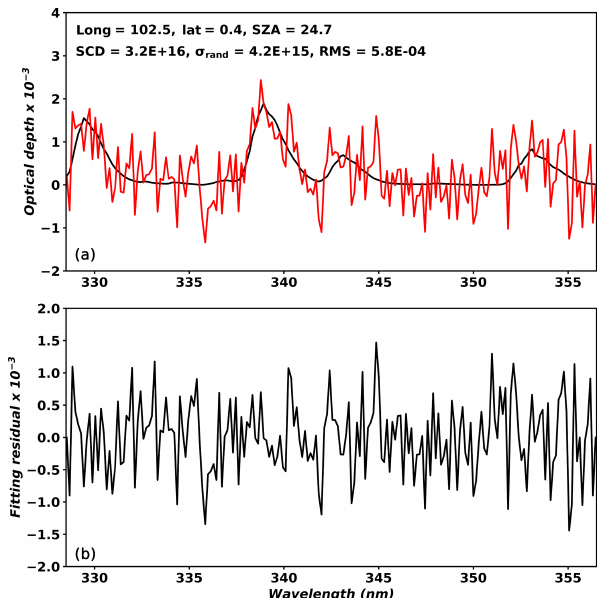
Figure 7. Fitted HCHO optical depth (a) and fitting residuals (b) on a pixel (23 March 2005; orbit 3655) with a main data quality flag of 0 and an effective cloud fraction less than 0.3. In (a) , the black solid line indicates optical depth, and the red solid line indicates HCHO optical depth plus fitting